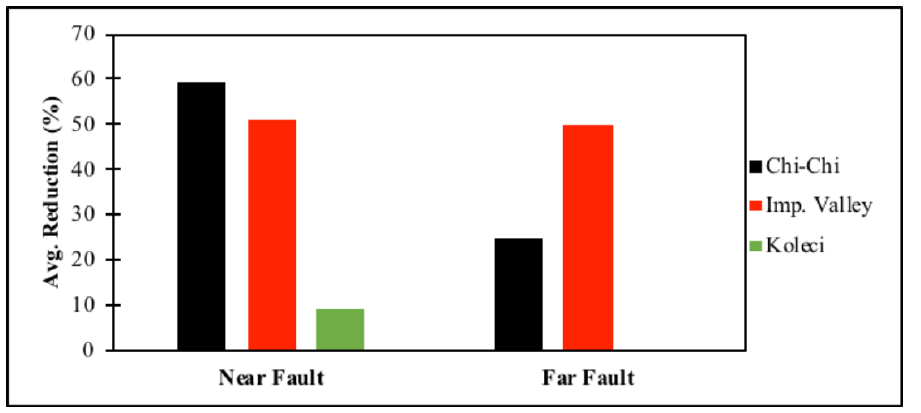
Figure 16. Average acceleration response